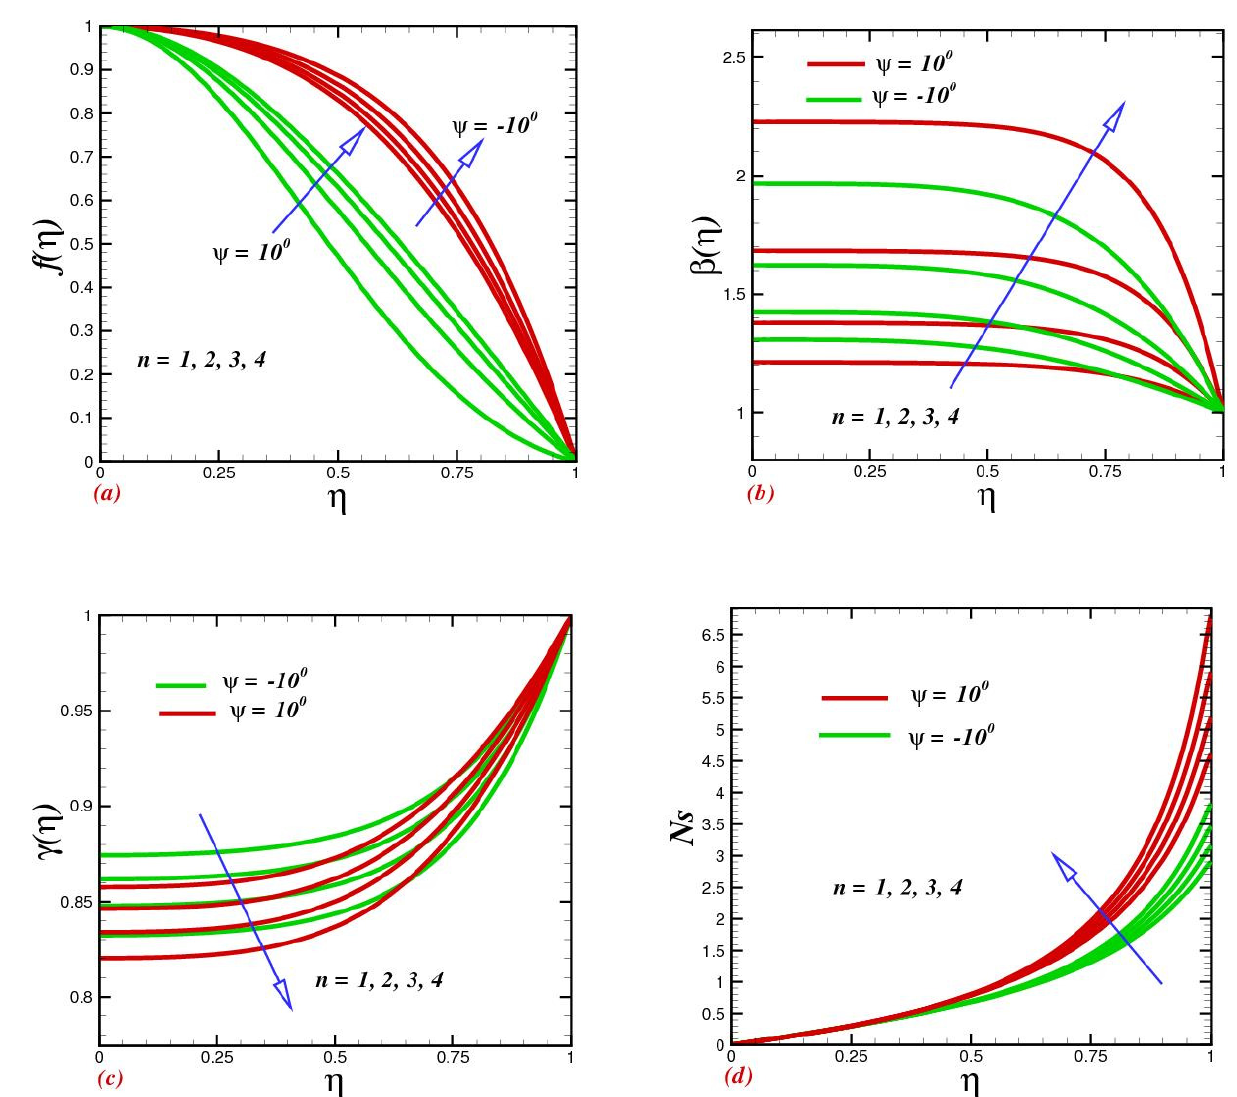
Figure 4. Impact of power-indexed parameter 𝑛 on ( a ) velocity 𝑓(𝜂) , ( b ) temperature 𝛽(𝜂) , ( c ) concentration 𝛾(𝜂) , and ( d ) entropy production 𝑁𝑠 .